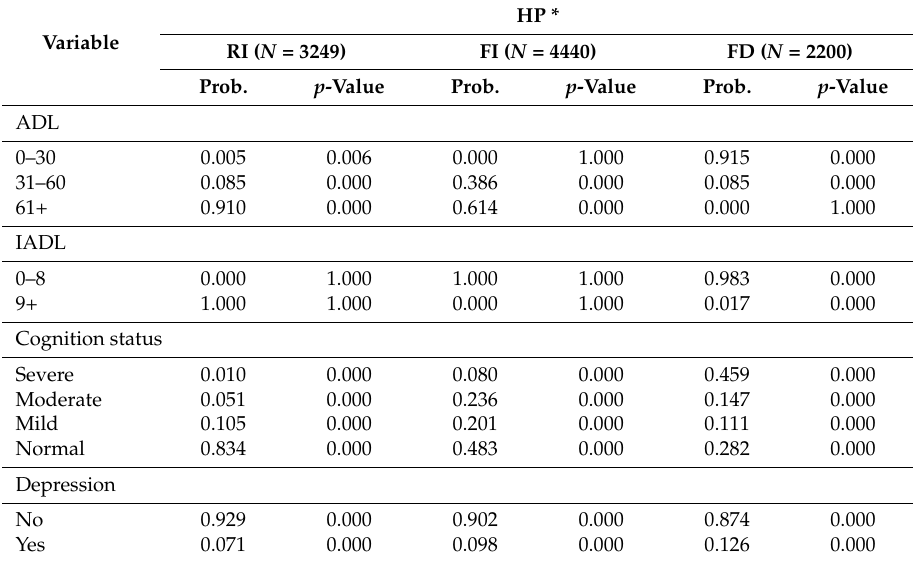
Table 1. Health profiles of the LTC recipients by using Latent Class Analysis.